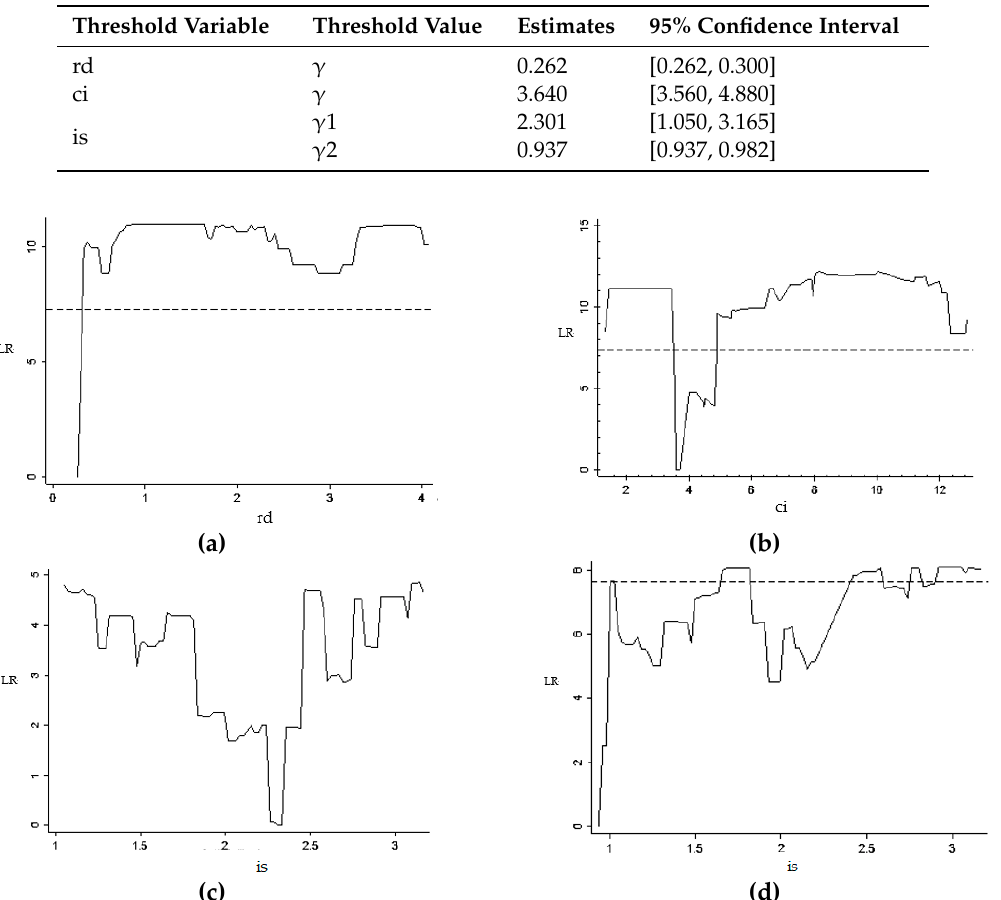
Table 7. Threshold estimation results and confidence intervals of foreign investment and carbon